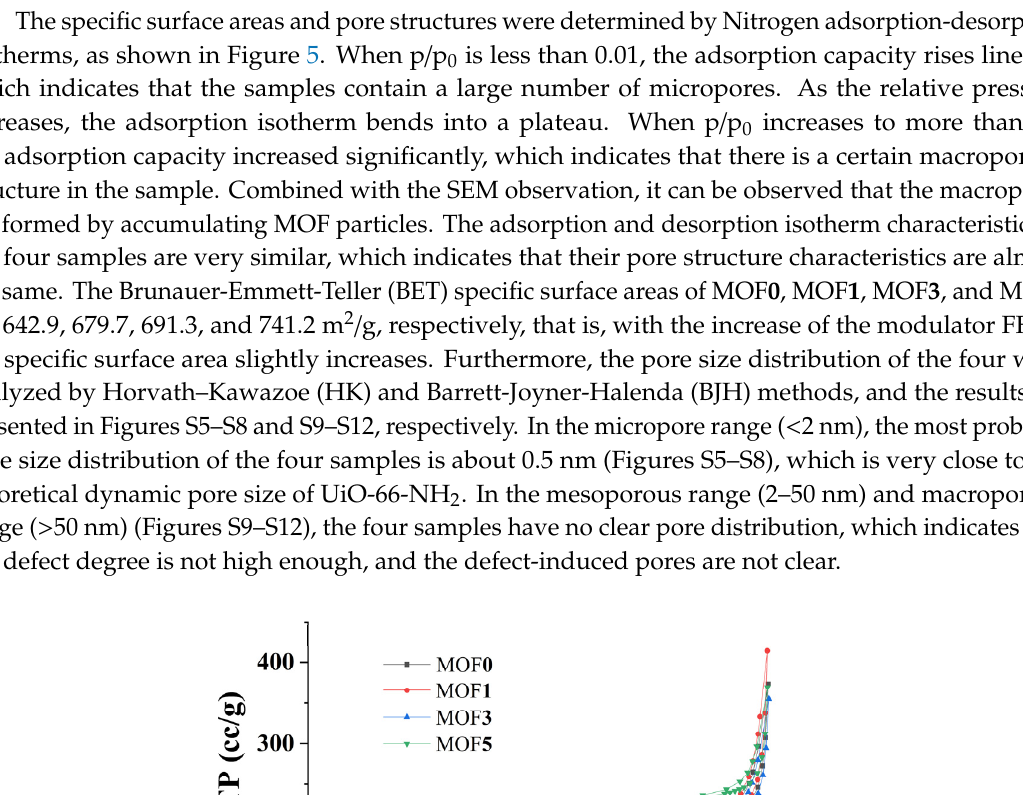
Figure 4. Thermogravimetric curves of the obtained MOF products.